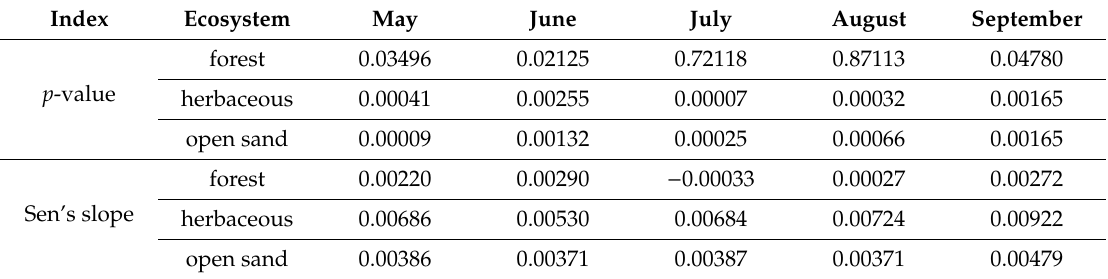
Table 3. Indexes of NDVI trends variation during growing season (May–September), Mann-Kendall Test, α =